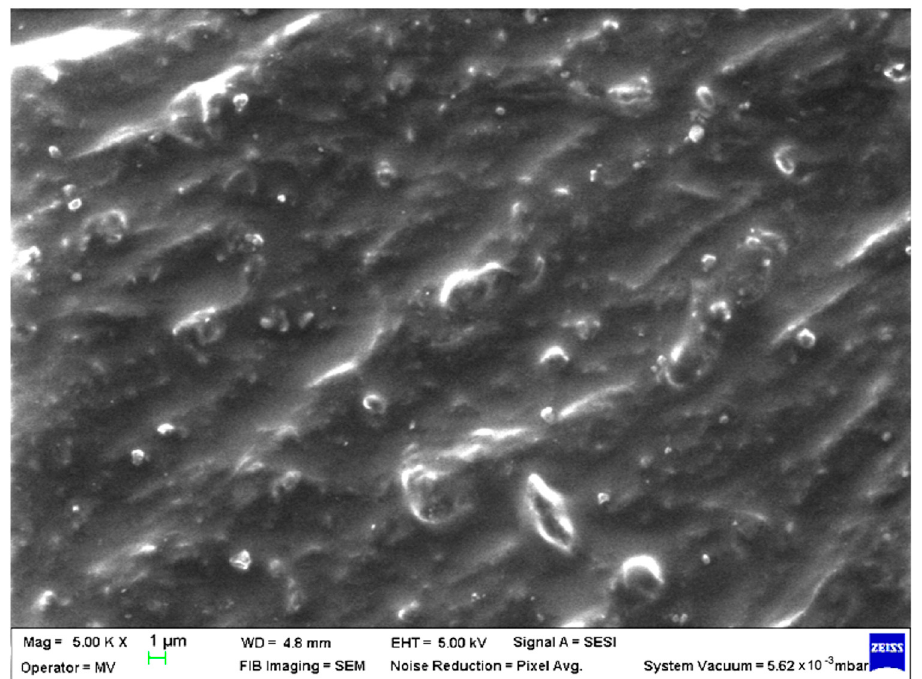
Figure 1. SEM micrographs of PET (M1) sample at T 0 (1 μ m scale).